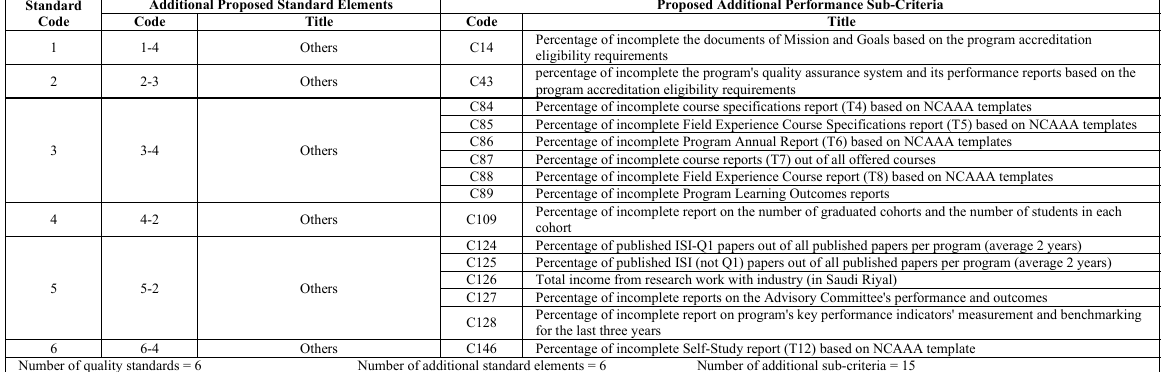
Additional sub-criteria related to NCAAA team visit requirements